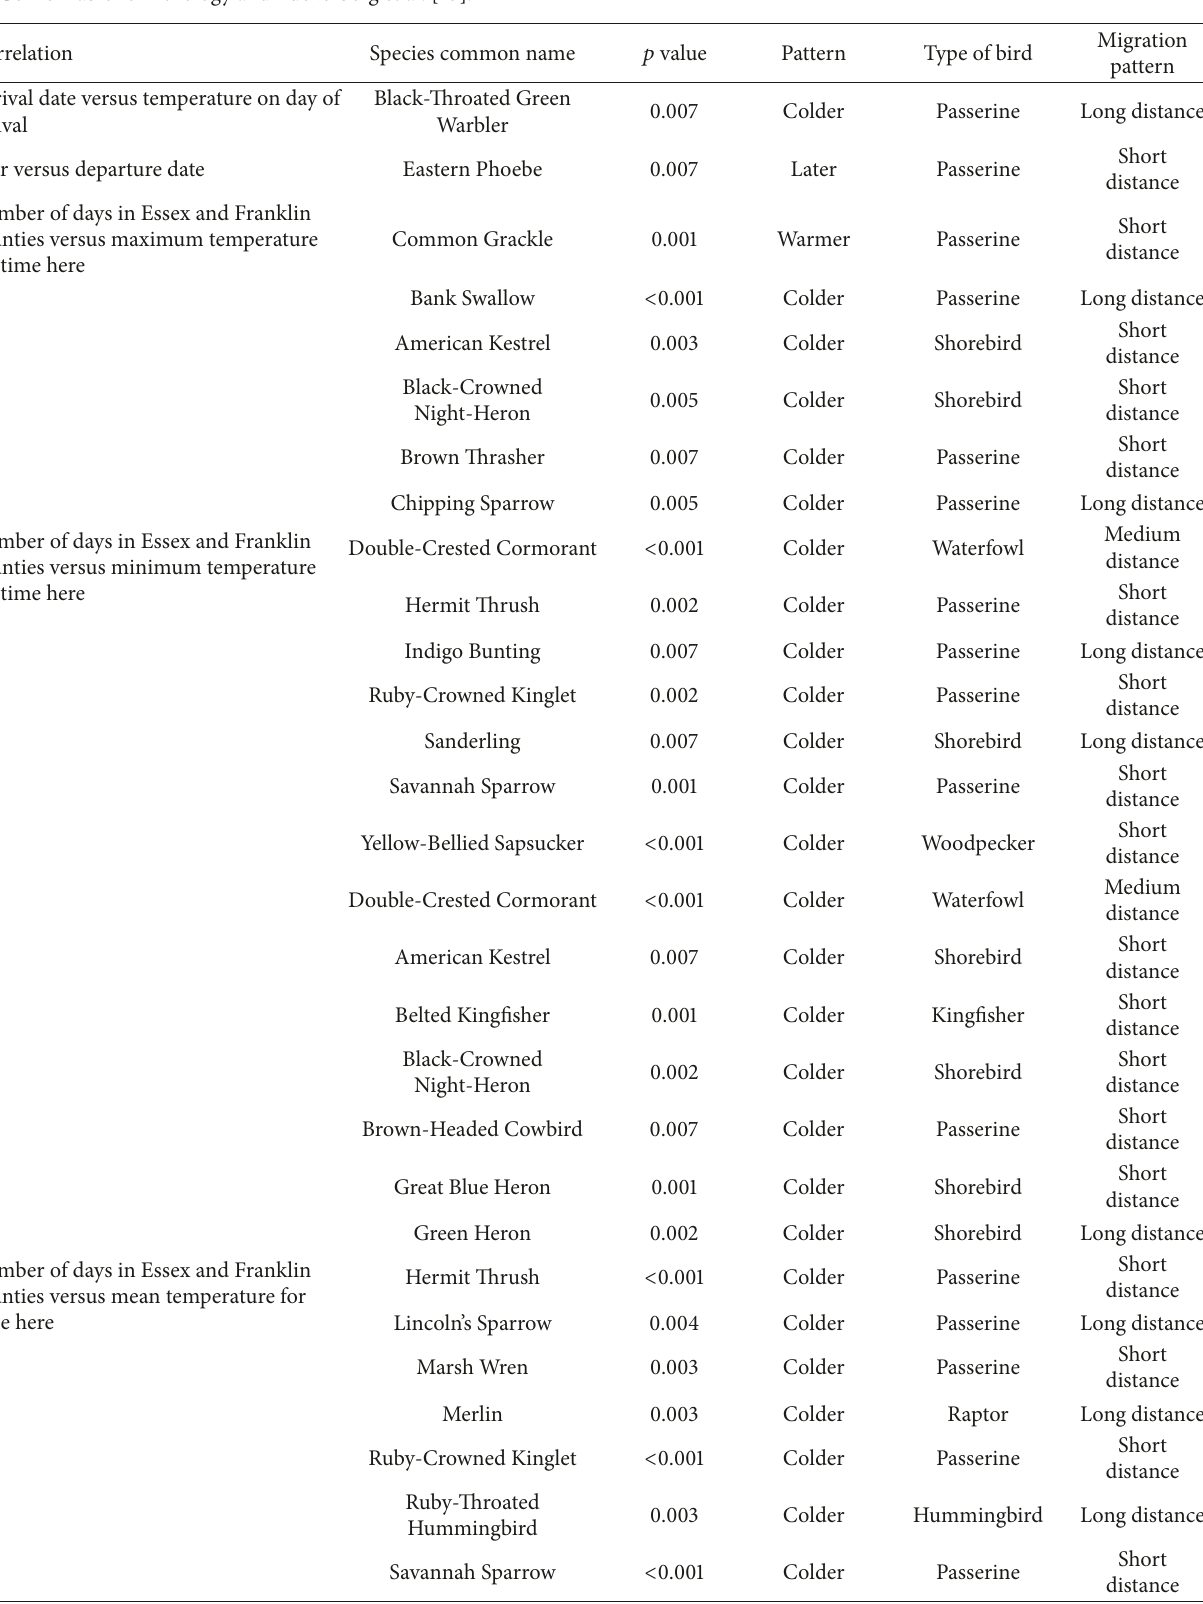
Table 3: Migration timing changes and significant environmental temperature changes experienced by species showing a one-stopover migration strategy through Essex and Franklin counties in the Adirondack region. Migration patterns were determined using data from the Cornell lab of ornithology and Zuckerberg et al.